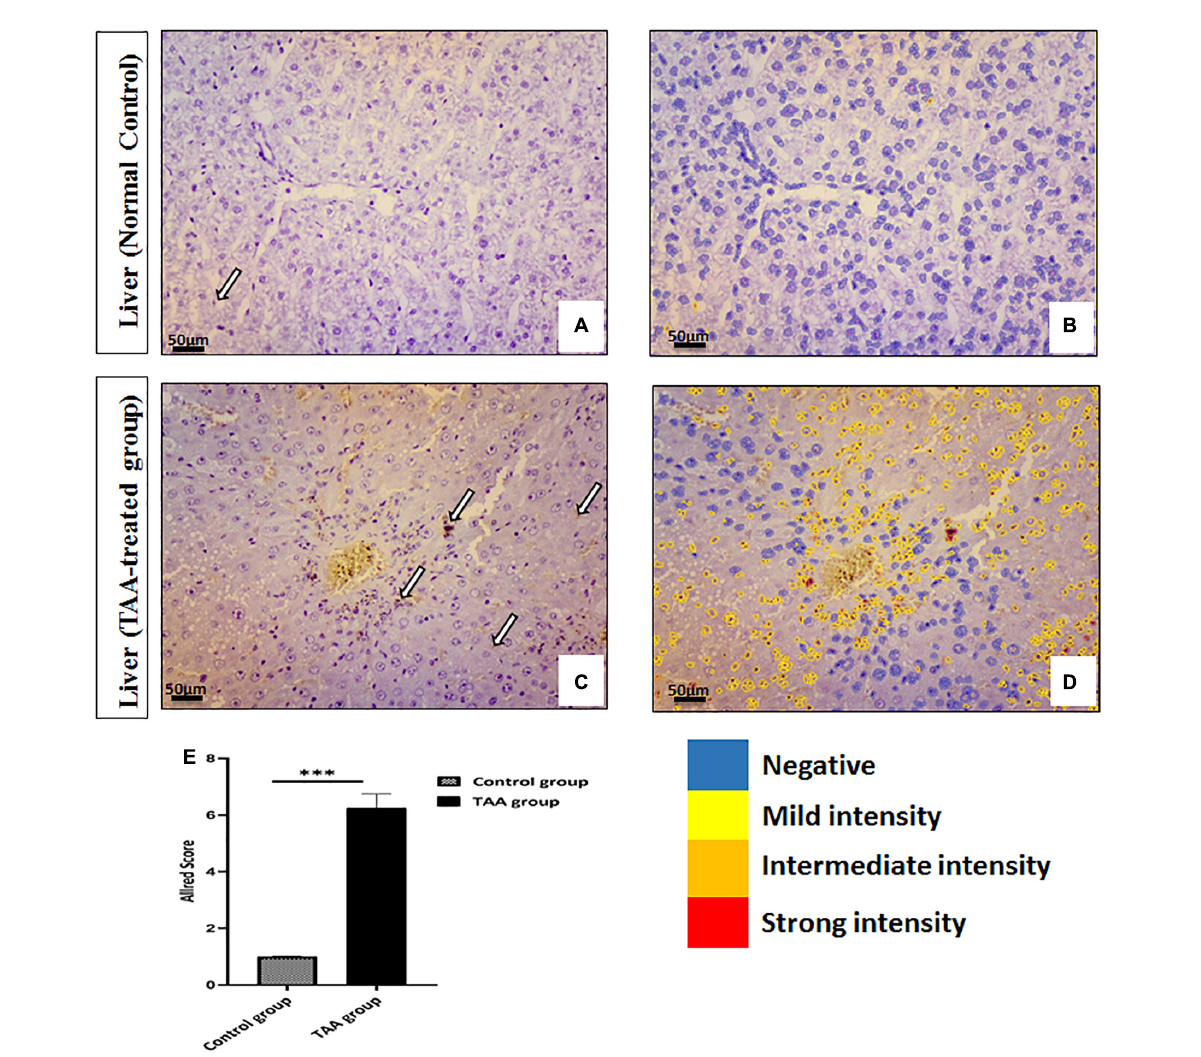
FIGURE4 (A–D) Liver sections of control and TAA-treated groups stained with ki-67. (A,B) Control groups. (A) Very rare immunopositive hepatocytes (arrow). (B) Quantitative analysis of cells showing negativity and mild intensity. (C,D) TAA-treated groups. (C) An increased number of immunopositive nuclei of hepatocytes (arrows). (D) Quantitative analysis of cells showing different intensities varying from mild to strong. X: 400 bar 50. (E) Allred immunohistochemical scoring system. Data are expressed as mean ± SD. 0–1 (negative), 2–3 (mild), 4–6 (moderate), and 7–8 (strong). ∗∗∗ p < 0.001 vs. control